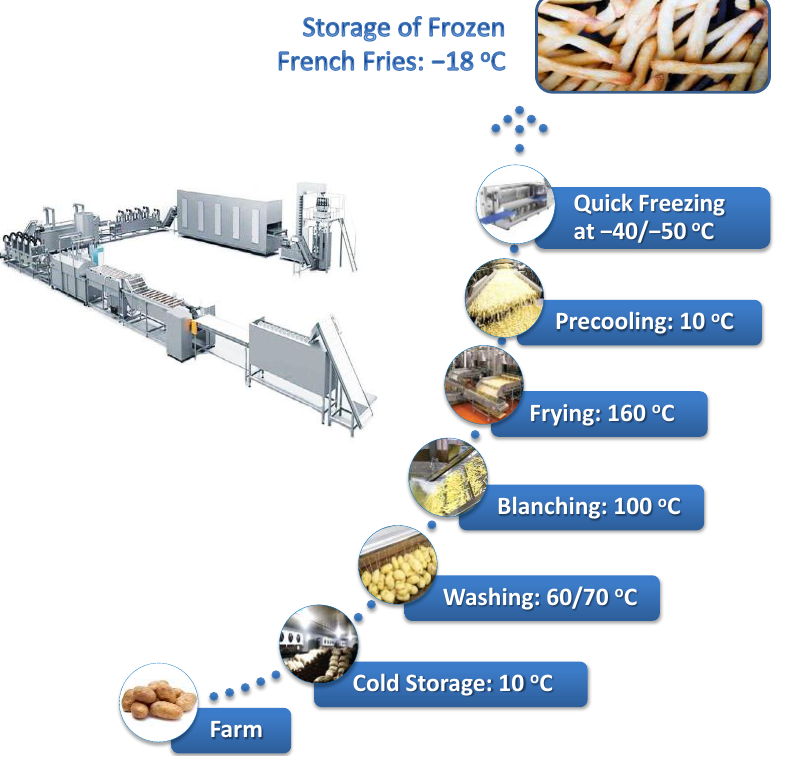
Figure 4. Main processes (unit operations) in a production line for frozen French fries involving substantial heating and refrigeration demands.